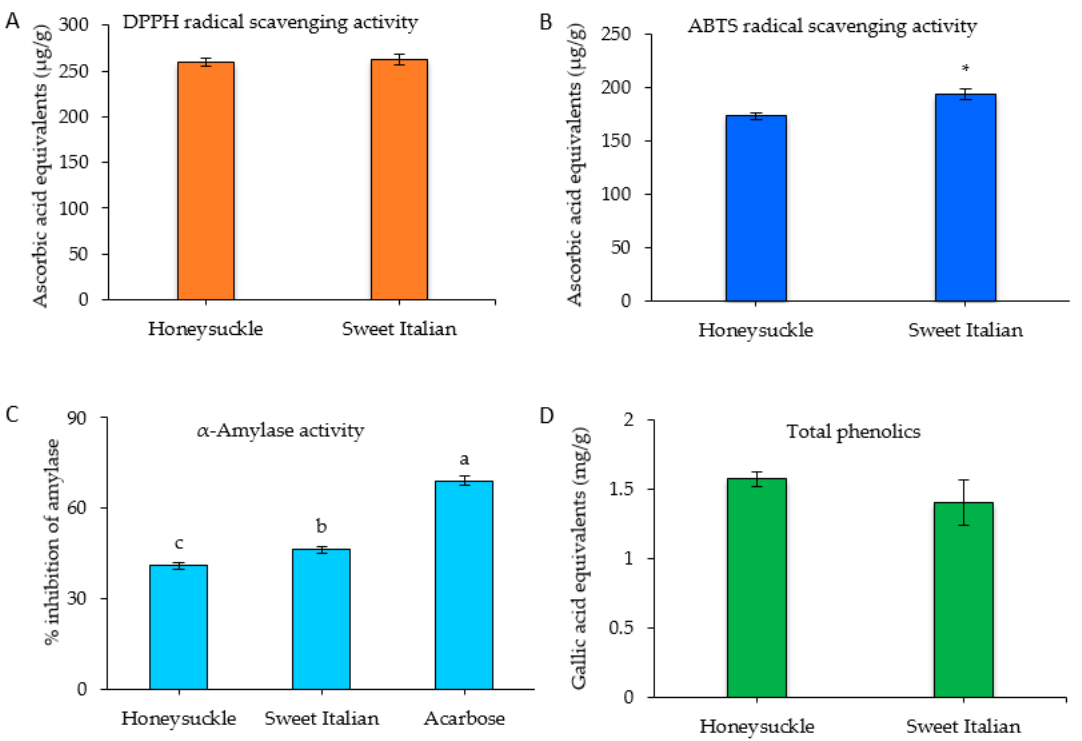
Figure 3. ( A ) ABTS, ( B ) DPPH, ( C ) α -amylase activity, and ( D ) total phenolic content of red onion juice. * Different letters (a, b, c) above the bars of each cultivar indicate statistically significant differences determined by a Student’s t-test at p < 0.05.